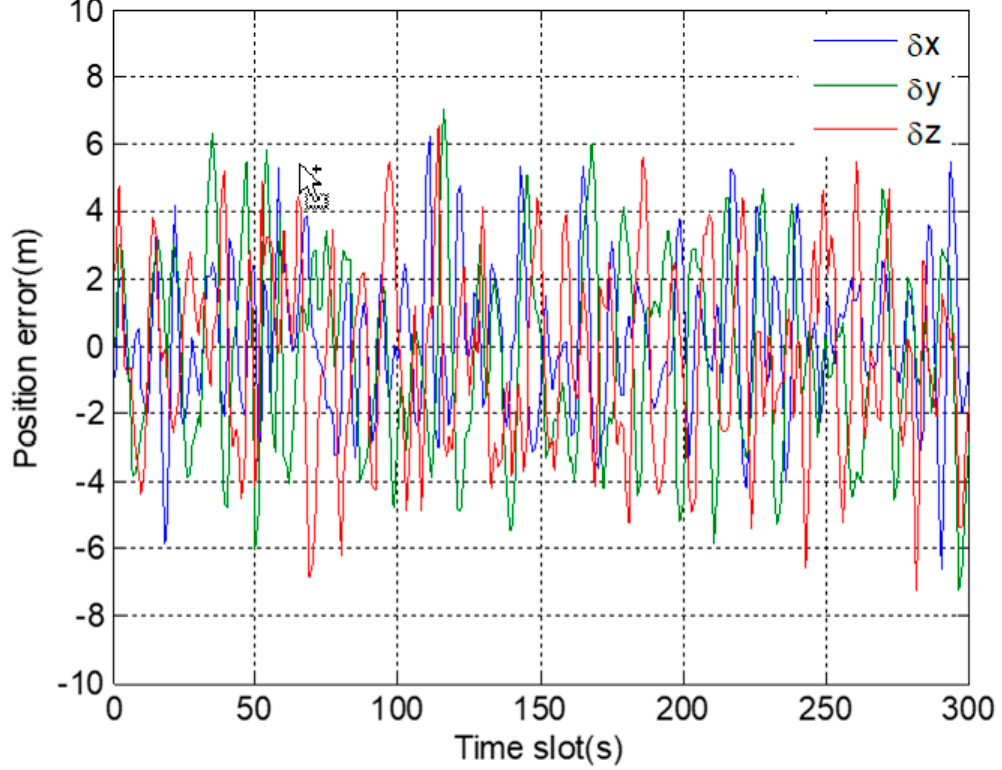
Figure 17. Position errors in 3D direction after isolating the fault